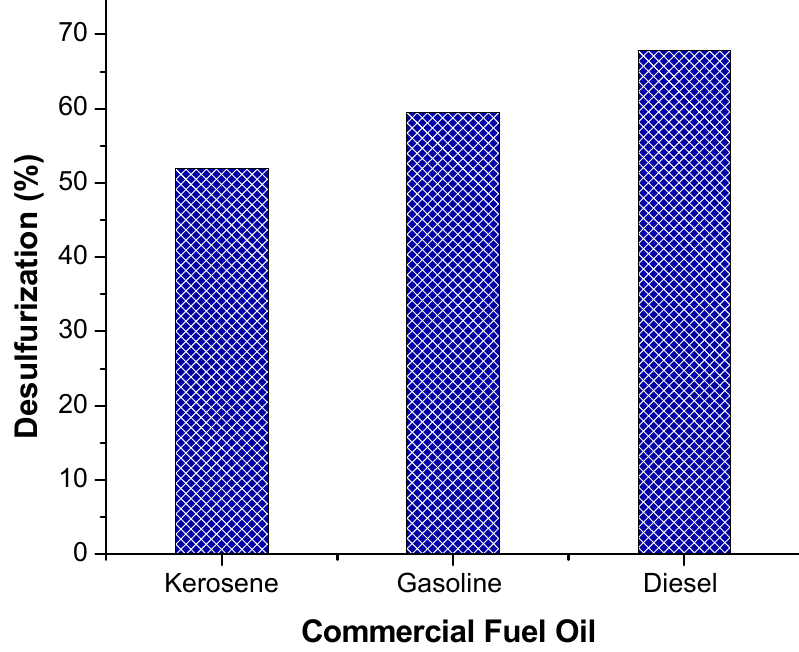
Figure 8. Desulfurization (%) of commercial fuel oil at 40 °C temperature and reaction time of 60 min in the presence of MnO 2 /MrGO , fuel volume (15 mL), catalyst weight (0.08 g), oxidant volume (2 mL), reaction time (15 min), and temperature (40 °C).